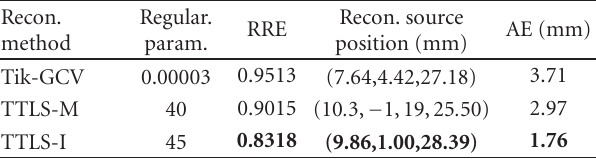
Table 5: Reconstruction results in physical phantom experiment. Recon.